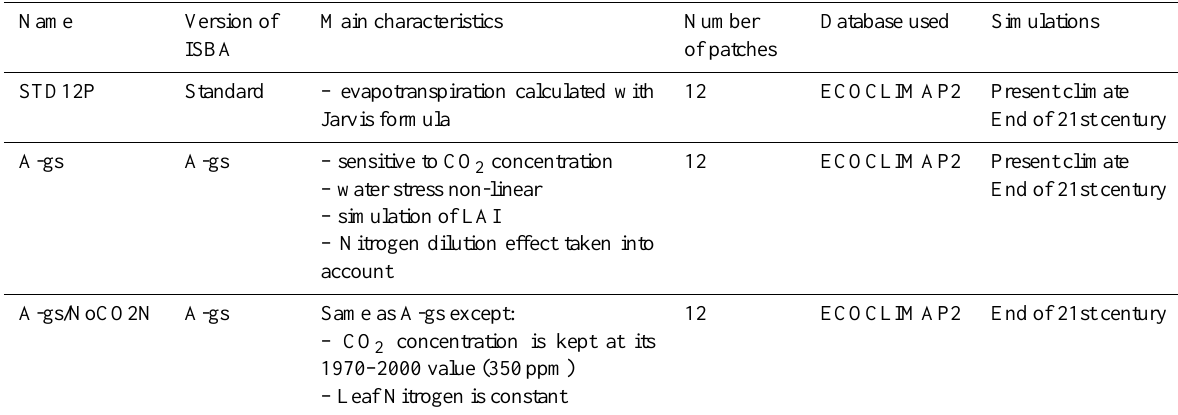
Table 1. Summary of the different versions of ISBA used and their